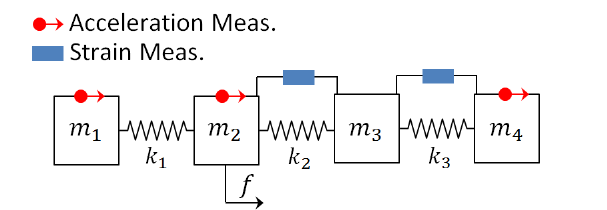
Figure 3. Four Degree of Freedom system with one excitation on the 2nd